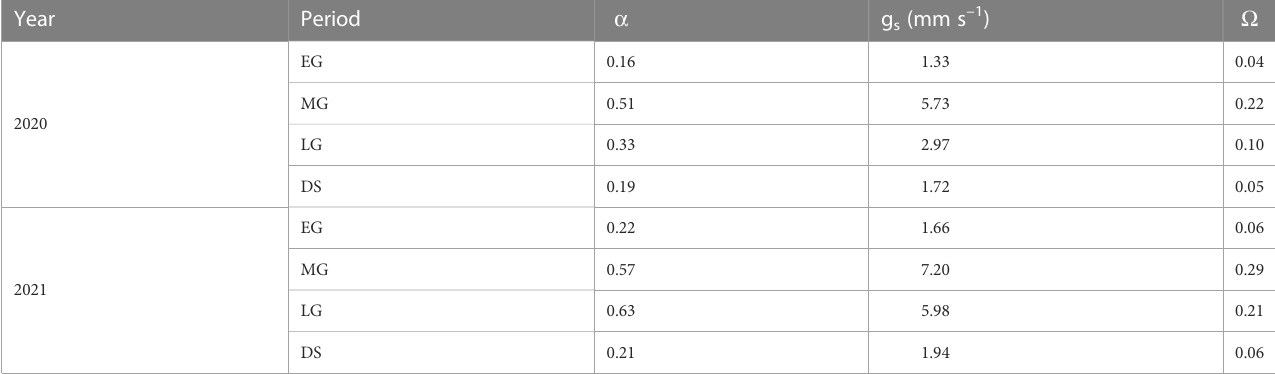
TABLE A3 Average midday Priestley – Taylor coef fi cient ( a ), surface conductance (g s ), and decoupling coef fi cient ( W ) during the early growing stage (EG), the mid growing stage (MG), the later growing stage (LG), and the dormant season (DS) in 2020 and